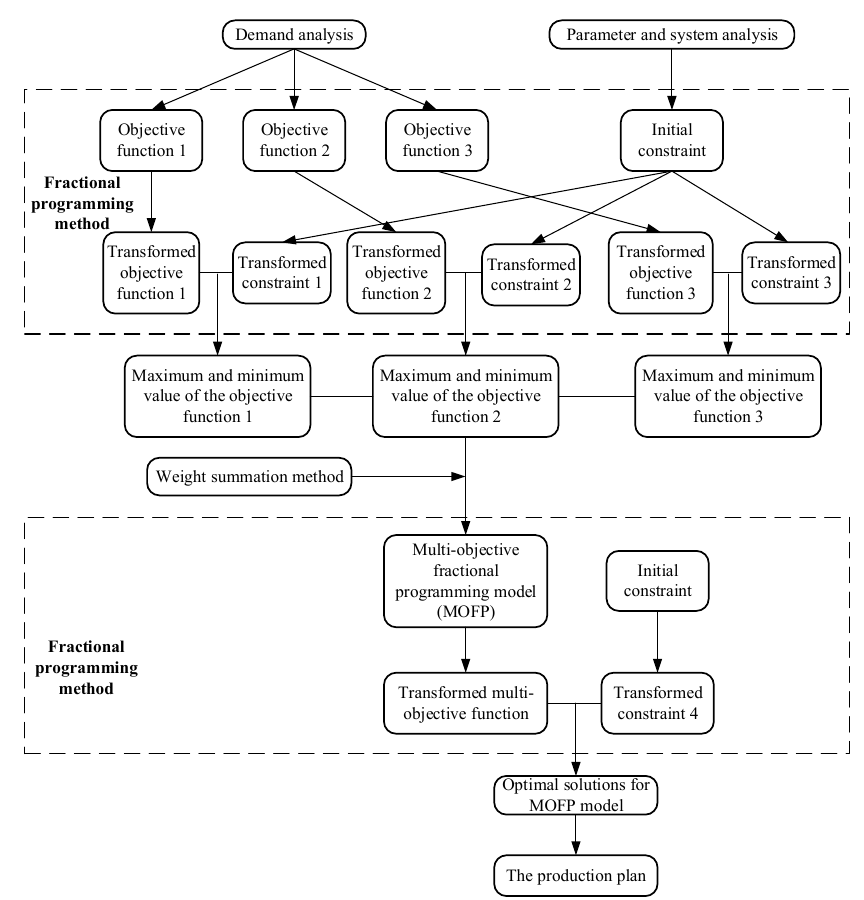
Figure 2. The formulation and solution framework of the MOFP model.